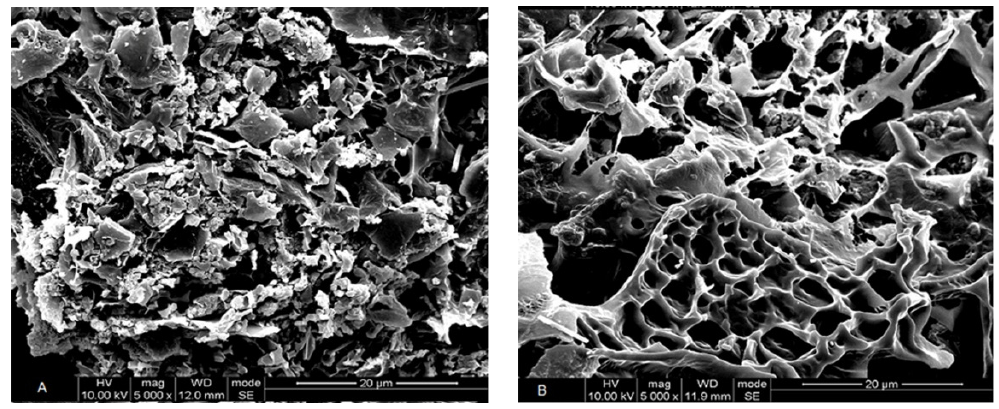
Figure 4. Scanning electron microscopy of L. punctata mash before and after pectinase pretreatment: ( A ) untreated L. punctata mash; ( B ) L. punctata mash pretreated by pectinase under optimal